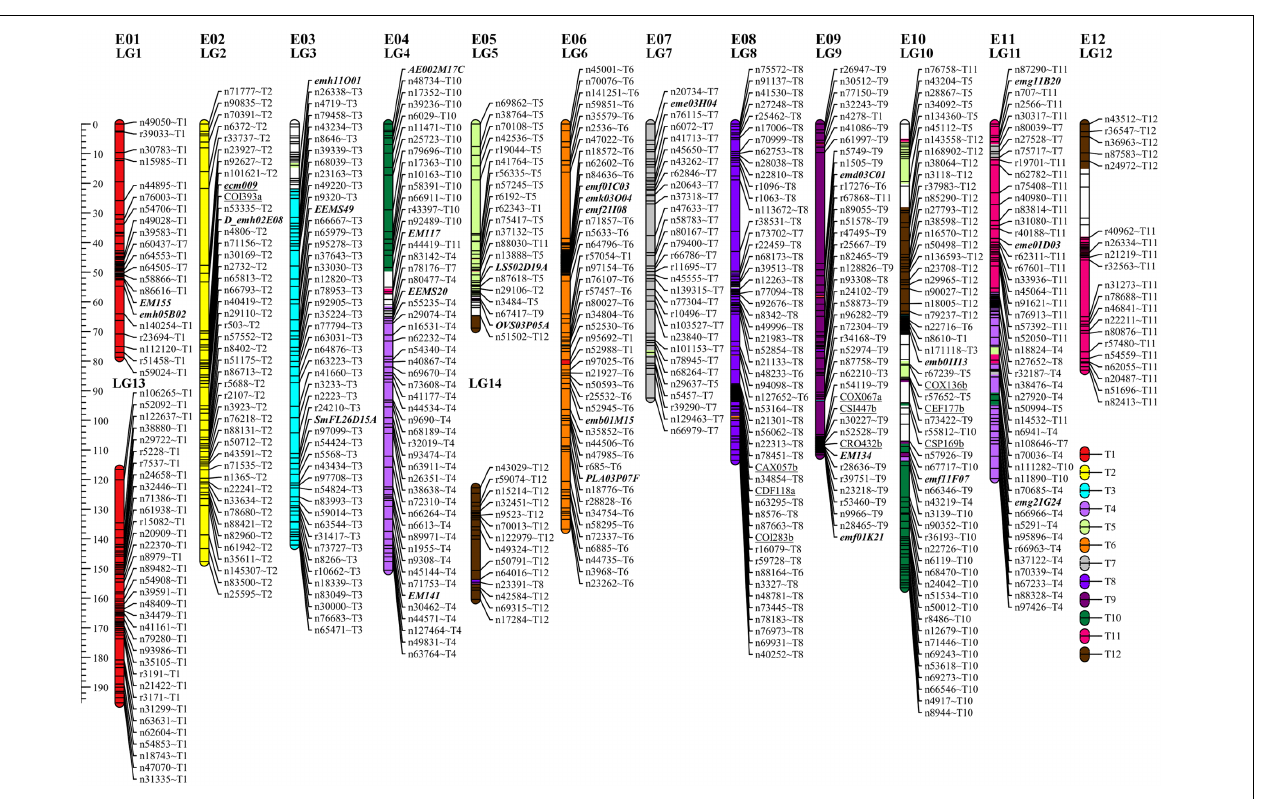
Frontiers in Plant Science |